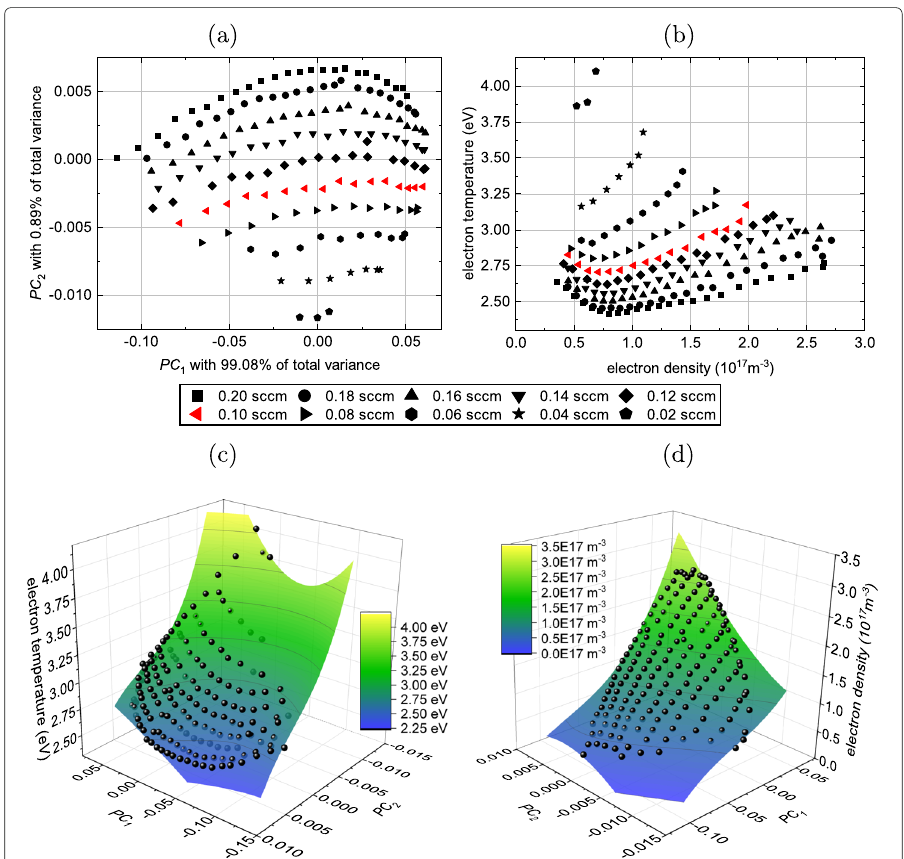
Fig. 6 PCA scores from the cw OES measurements of a xenon plasma ( a ) and the corresponding electron temperatures and densities from the simultaneously conducted Langmuir double probe measurements ( b ). The PCA scores of the spectra shown in Fig. 5a from the 0.10sccm measurement series (shown in red here) are clearly distinguishable. The input power increases from left to right in both plots (a) and ( b ). The fits of the electron temperature ( c ) and density ( d ) over the PCA scores are the depict correlation between OES and plasma